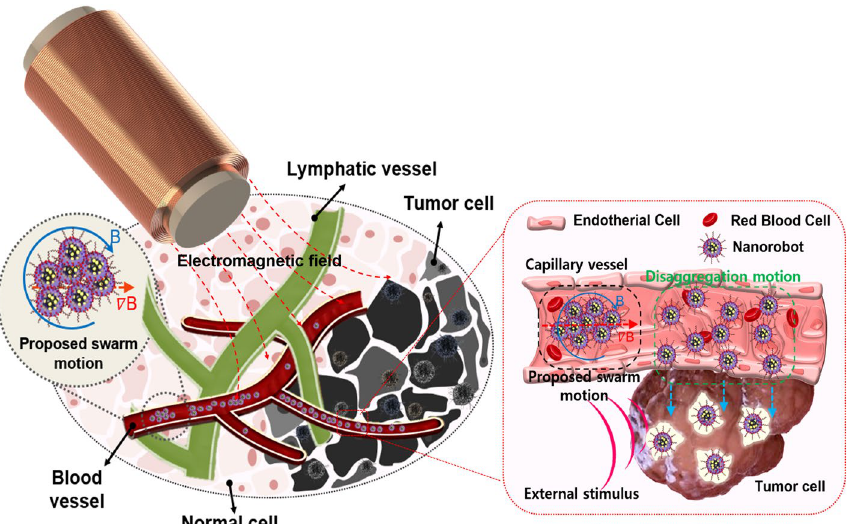
Figure 1. Conceptual schematic of targeted drug delivery. Nanorobots are driven to targeted area by EnEMAs with proposed swarm motion and visualized by X-ray monitoring; enhanced tumbling motion steers magnetic clusters to reach target area, and disaggregation motion breaks cluster into smaller sizes to enter micro-vessels at site. Drug release is triggered by external stimulus after approaching target